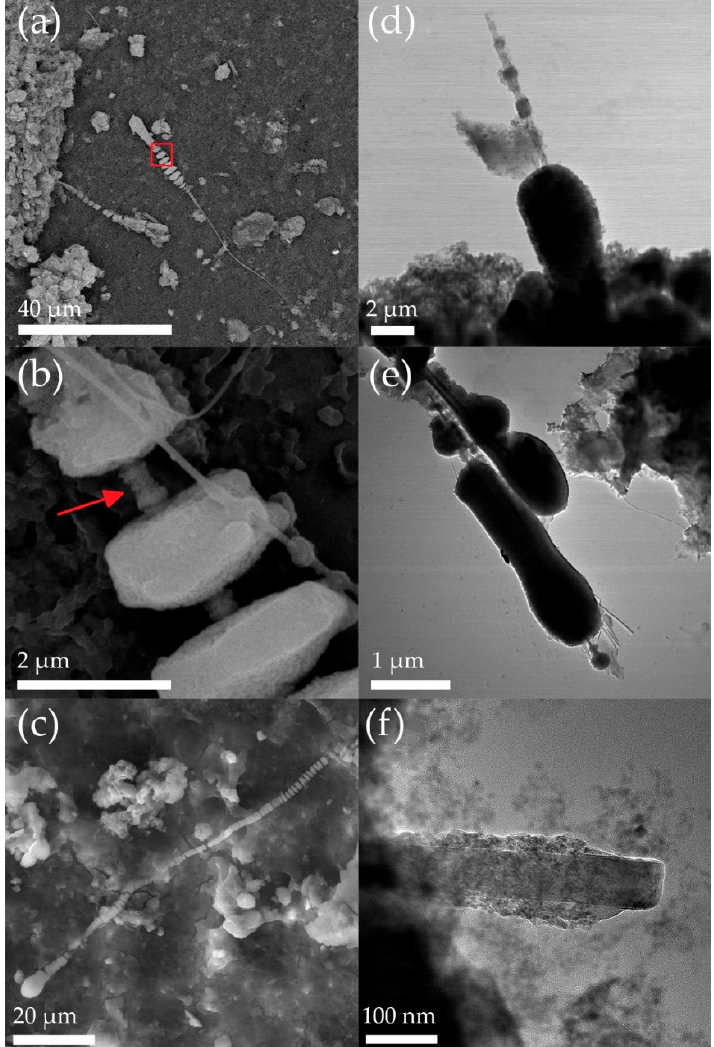
Figure 8. ( a ) FEG-SEM image showing an example of the beaded shape of asbestos bodies (ABs). ( b ) Close-up of red square shown in image ( a ). Image showing the beaded shape with the red arrow indicating the space between individual AB segments covered by a secondary coating. AB segments show sub-cylindrical shape. ( c ) FEG-SEM image showing the typical beaded shape of ABs. AB and associated fibre cores are curved. ABs show sub-cylindrical segments spaced evenly along the fibre. The AB segment at the fibre tip is sub-rounded. ( d ) STEM image of a partially coated fibre with elliptical-shaped ABs; ( e ) STEM image showing a typical example of the apical AB segments at the tips of fibres. Segments are partially fused. ( f ) TEM image of a partially coated fibre. The AB appears as a smooth, corrugated coating of the fibre.